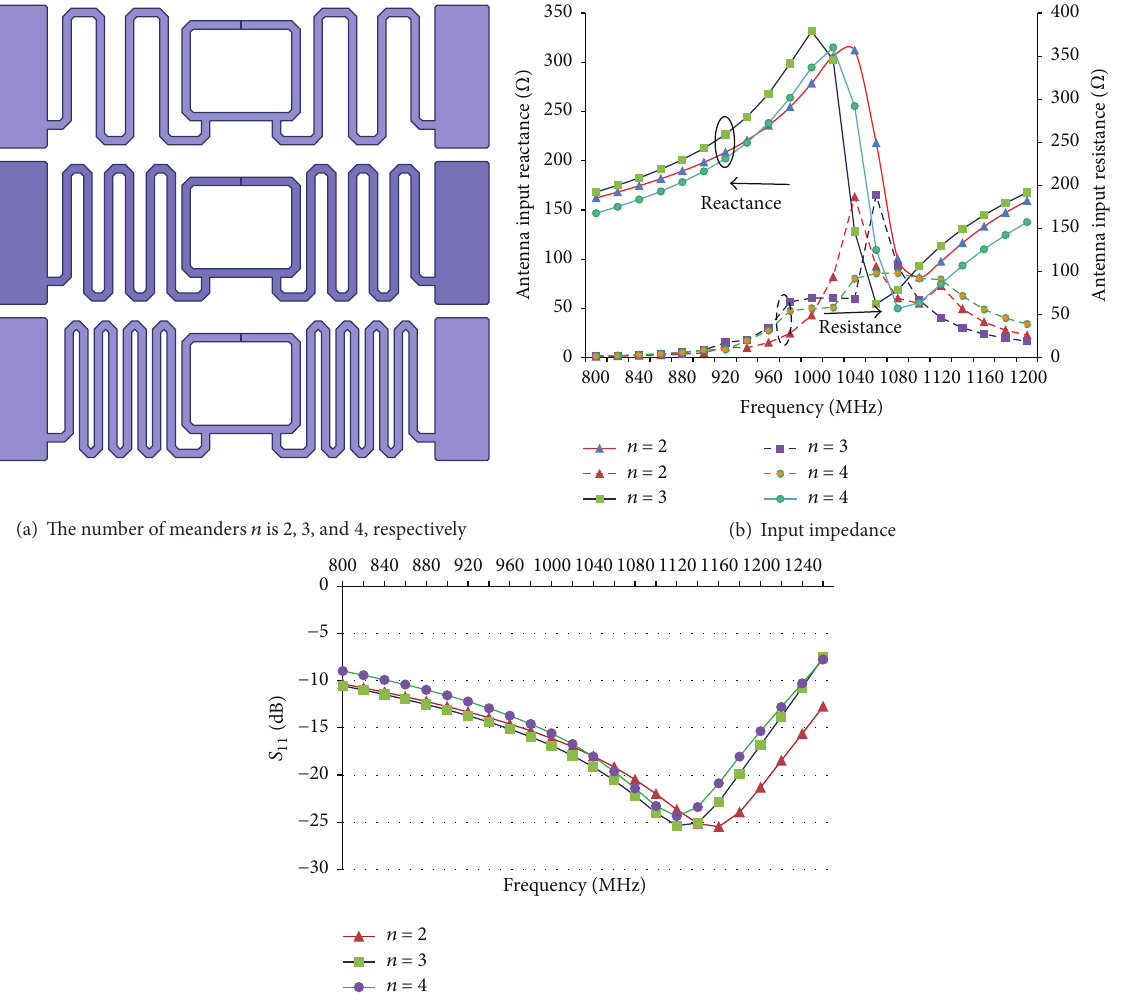
Figure 3: Simulated input impedance and reflection coefficients of tag antenna with different meanders.